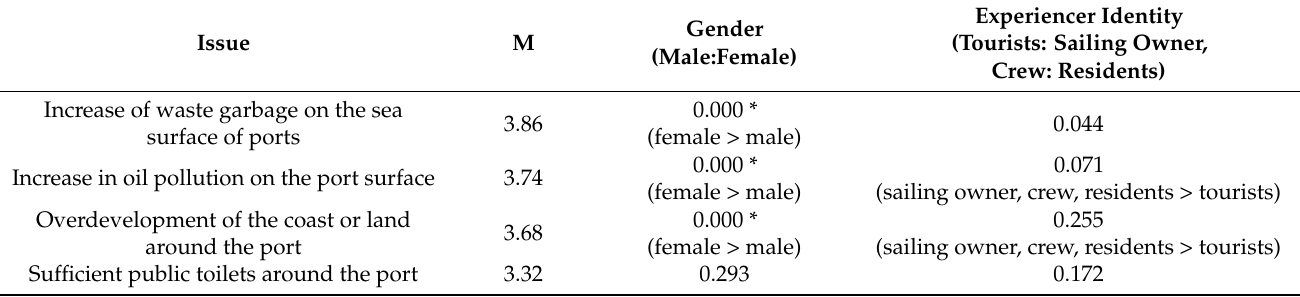
Table 7. Perception analysis of the impact on environmental hygiene at the port.